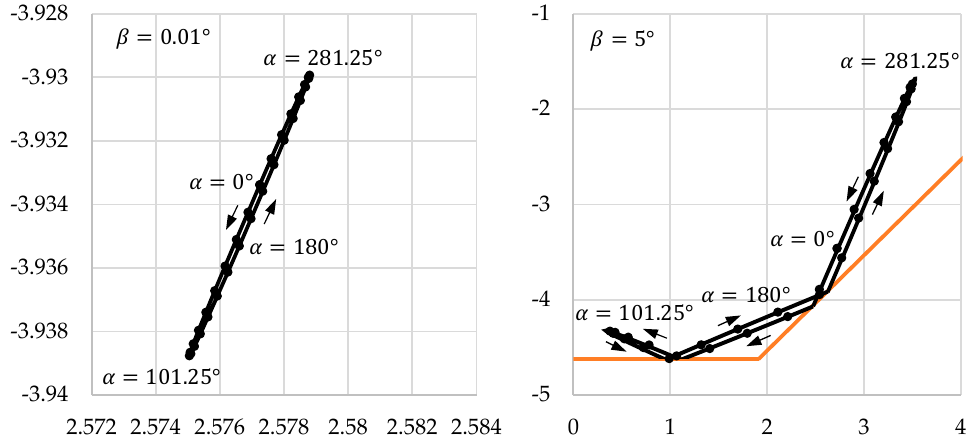
Figure 10. Position of the laser beam at the exit face in dependence of the bending orientation 𝛼 . One dot each 11.25° of 𝛼 . Left: bending angle 𝛽 = 0.01° , right: 𝛽 = 5° . Dimensions are in mm .